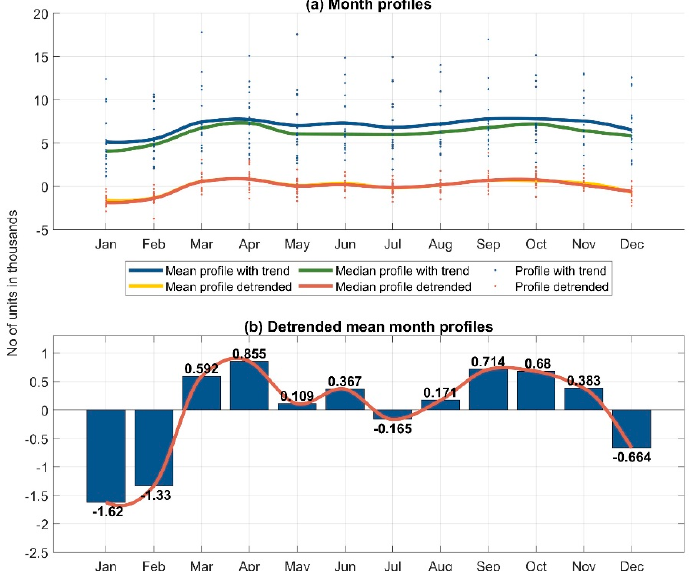
Figure 6. Averaged annual profile. Housing units whose construction has begun—sale or rental (Source: own compilation based on data from CSO).